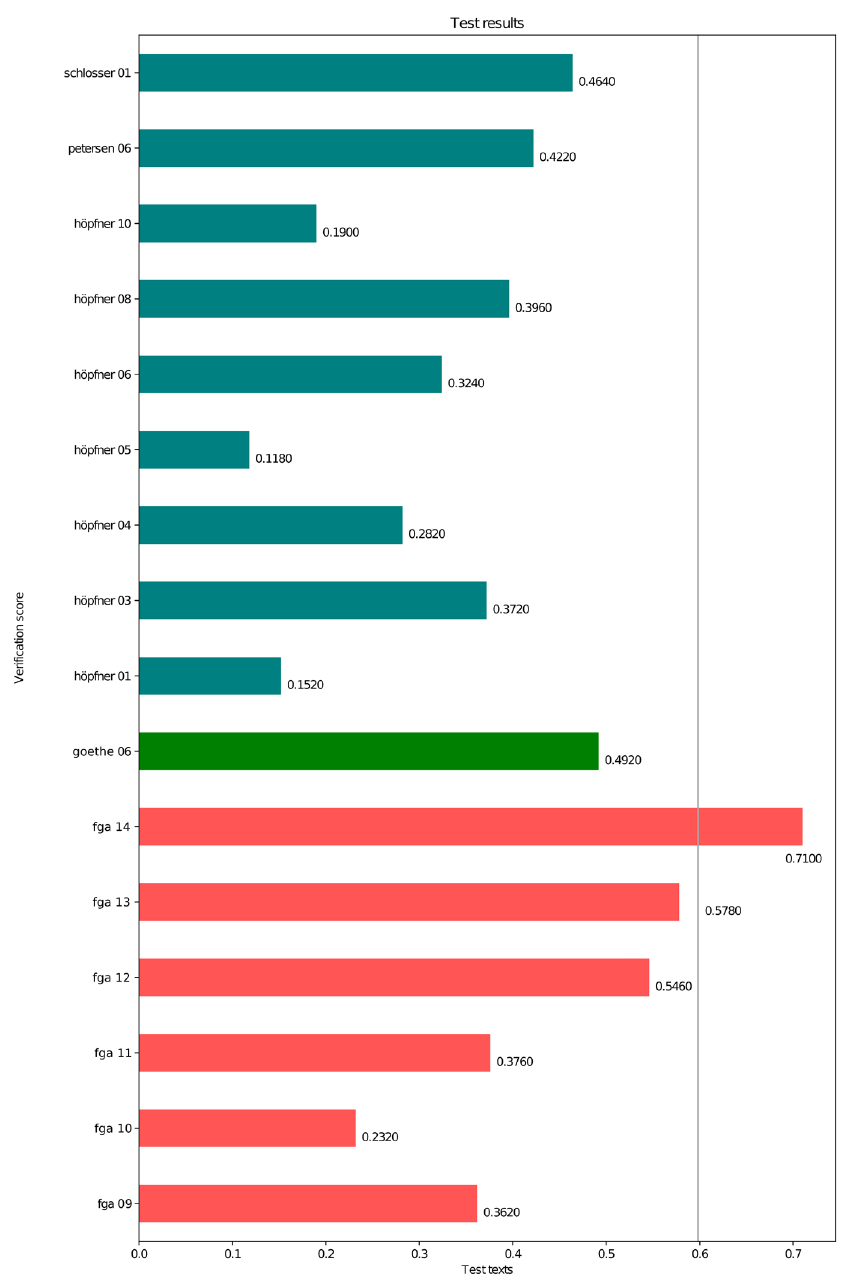
Fig. 4 Test set results for sample texts from FgA 1772 shorter than 2100 characters where authorship is regarded as either verified (green for Goethe, petrol for Höpfner and Petersen) or not verified, disputed or unclear